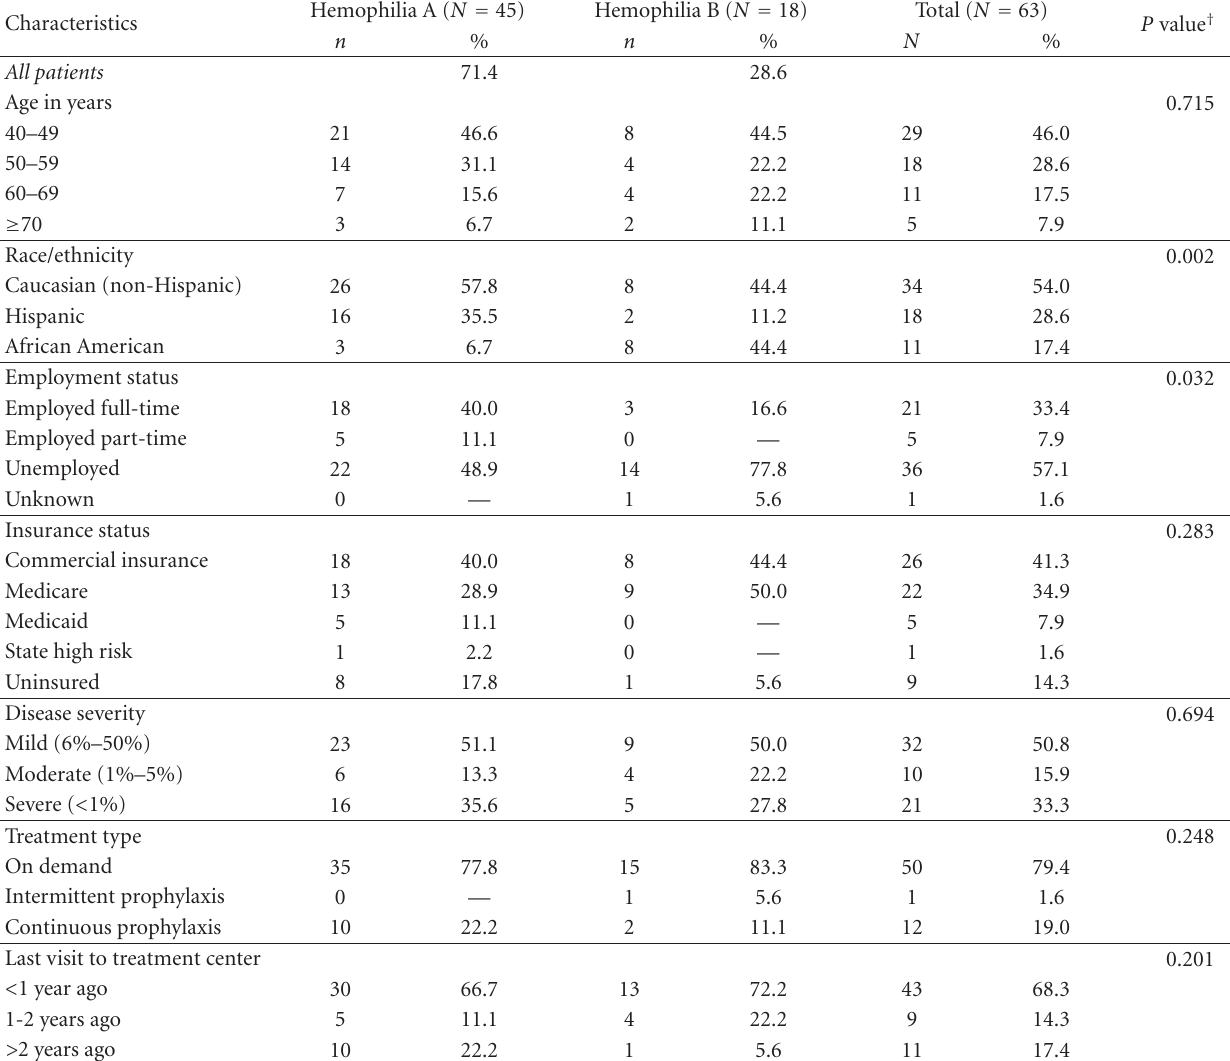
Table 2: Selected characteristics of patients 40 years of age or greater, who visited the Gulf States Hemophilia & Thrombophilia Center between January 1, 2007 and August 31, 2010, according to disease